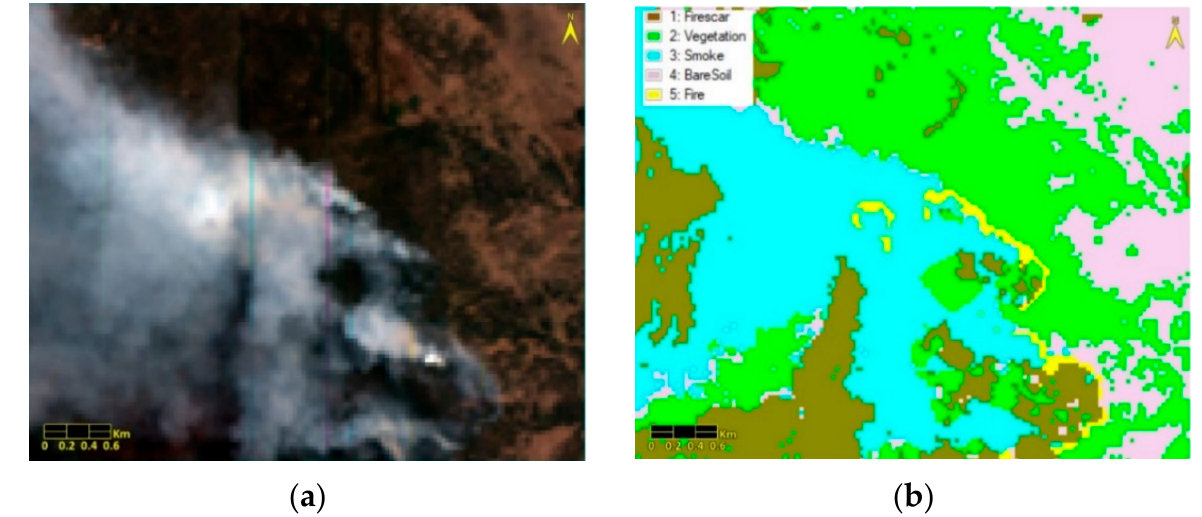
Figure 3. ( a ) RGB visible composition of PRISMA region of interest shows a dense fire smoke originating from diverse locations; ( b ) classification result corresponding to the selected region of interest (ROI) by using the complete VNIR–SWIR PRISMA spectral range. The yellow pixels correspond to active fire; light blue corresponds to the smoke class; brown, to freshly burned; green is the vegetation; and light pink, bare soil.